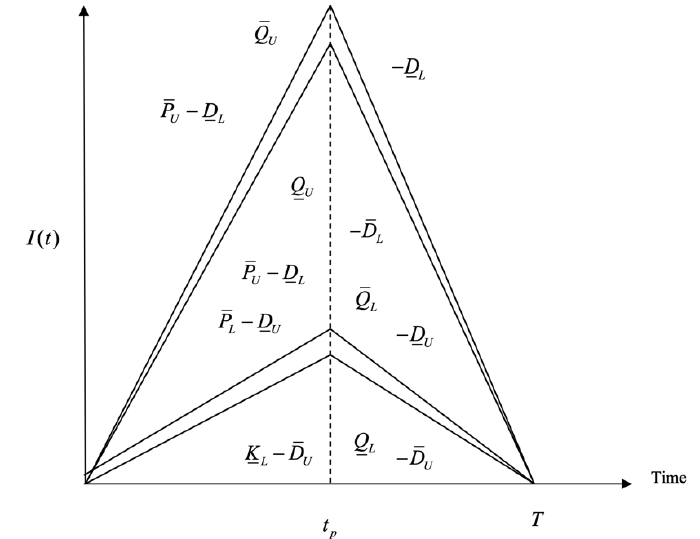
Figure 2. Inventory level I ( t ) at time t .